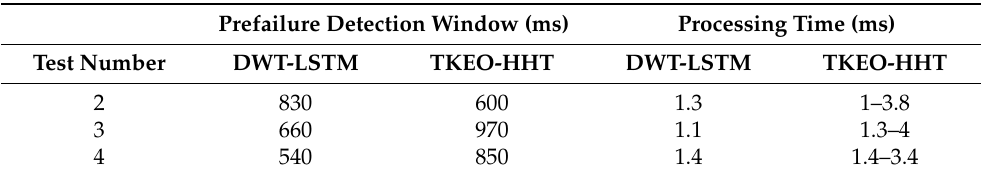
Table 2. Prefailure detection window and processing time of the DWT-LSTM and TKEO- HHT approaches.